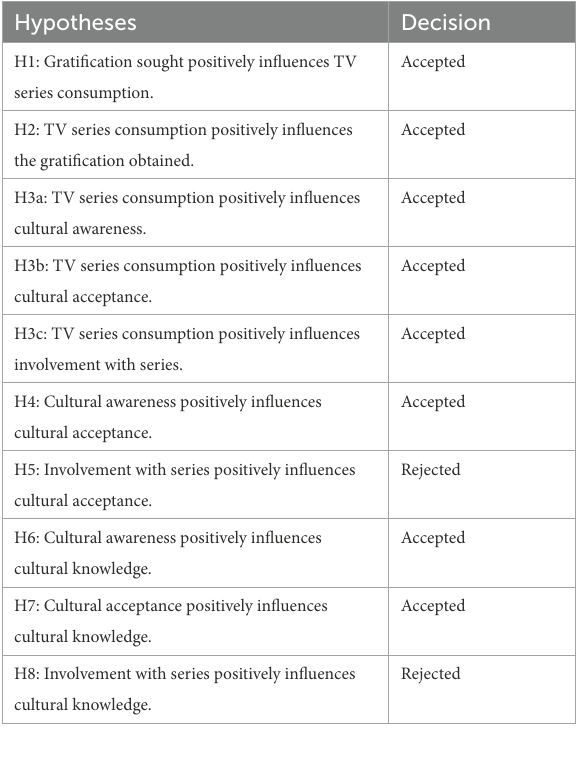
TABLE 7 Summary of research hypotheses.